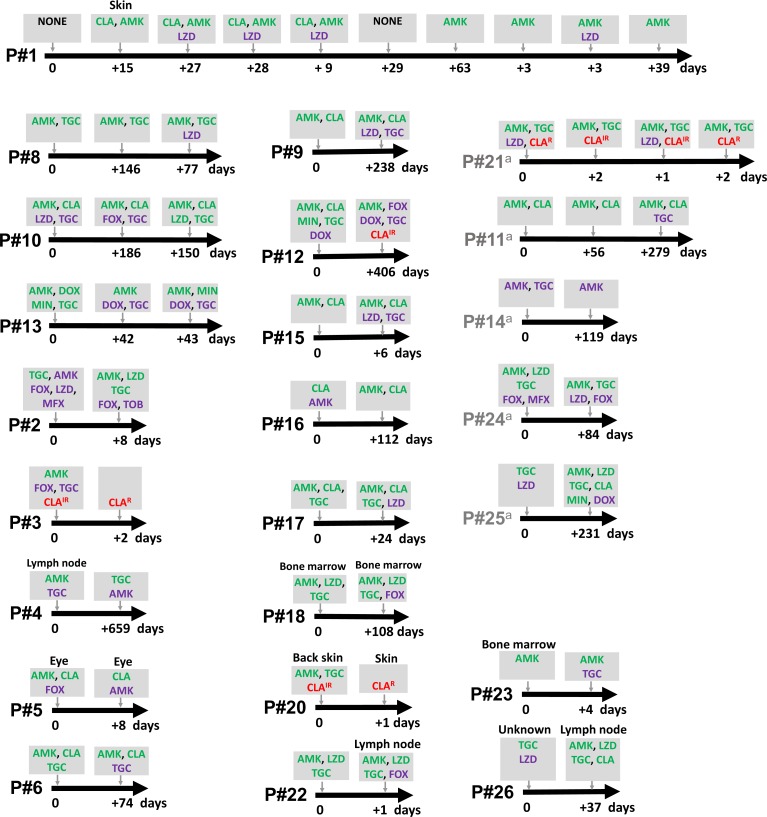
Drug susceptibility patterns of M. abscessus serially isolated from individual patients (P#1-P#26).Only susceptible (green letters) or intermediate (purple letters) levels of drug sensitivity are shown, except for “CLA” for which “IR” (inducible resistance) and “R” (acquired resistance) are shown. Organ sites are shown except pulmonary sites. Reinfection or recolonization strains (different strain among serial isolates– 2 patients) are excluded. “NONE” refers to resistance to all 15 antibiotics. The timeline shows number of days between successive samplings. a These cases were defined as colonization. AMK = Amikacin, FOX = Cefoxitin, CLA = Clarithromycin, DOX = Doxycycline, LZD = Linezolid, MFX = Moxifloxacin, Min = Minocycline, TGC = Tigecycline.